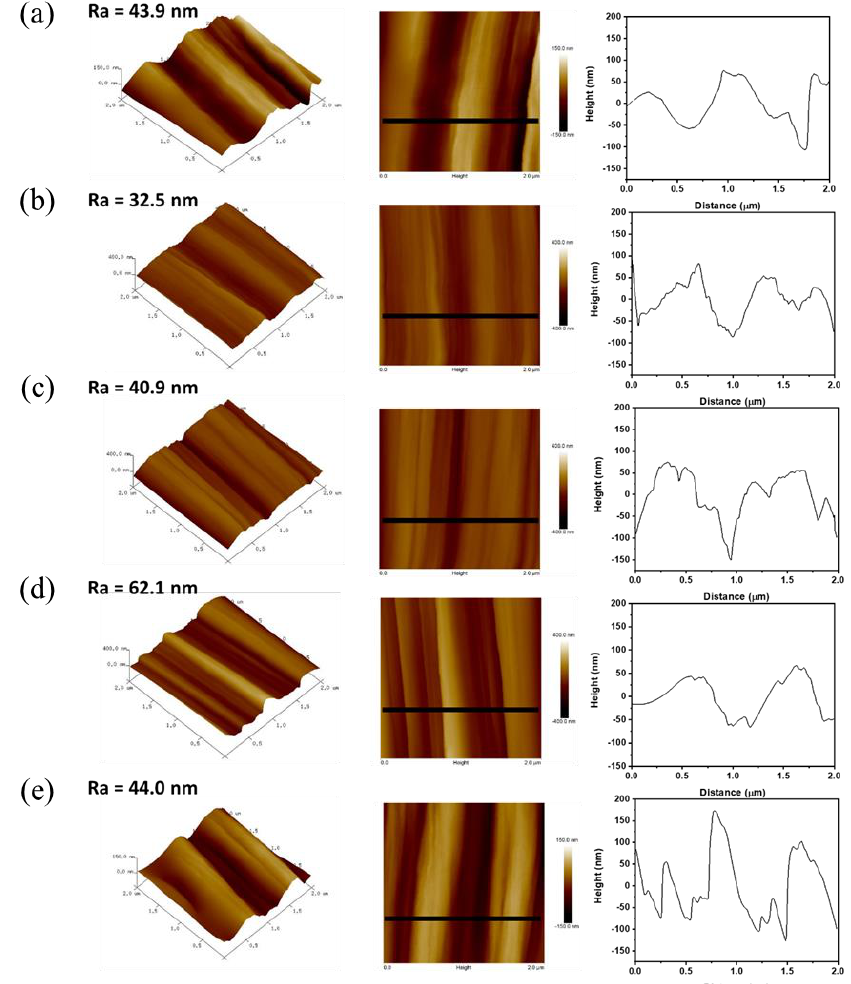
Figure 7. AFM images and height profiles for ( a ) C−CFs and ( b ) de−CFs, as well as ( c ) PI 0.5 wt%, ( d ) PI 1.0 wt%, and ( e ) PI 1.5 wt% of PI−sized CFs.